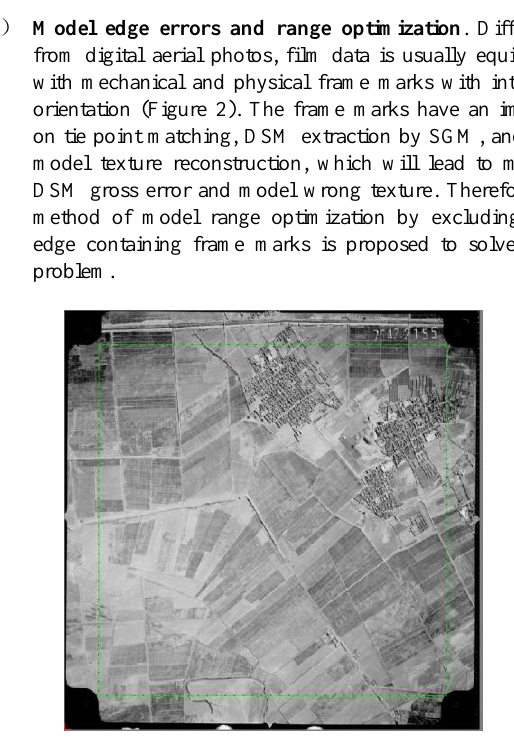
Figure 2. Range optimization by excluding the edge (outside the green lines) containing the frame marks in tie point matching, SGM matching and 3D